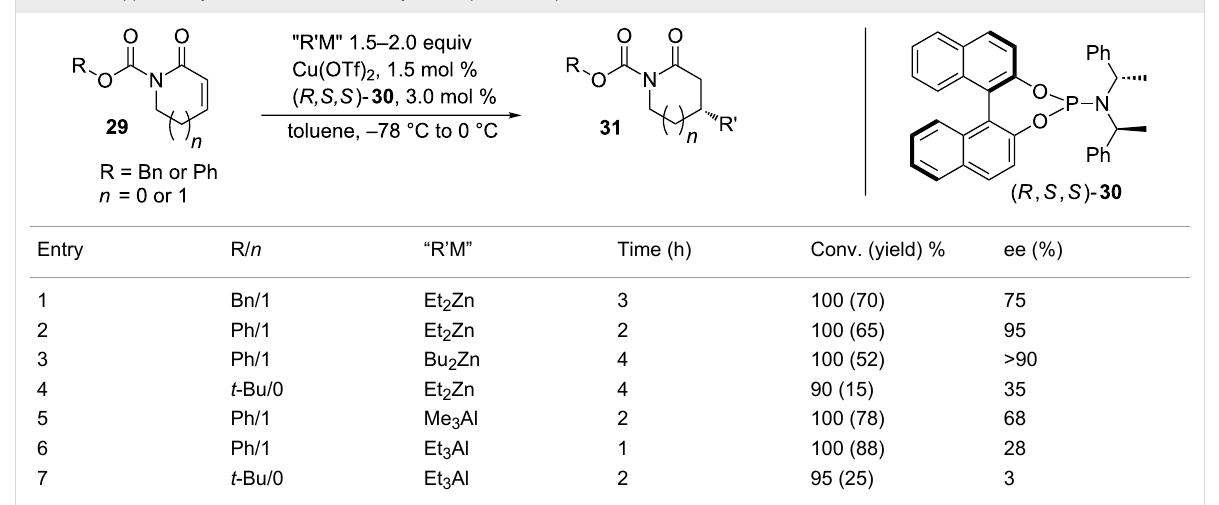
Table 1: Copper-catalyzed ECA reactions of alkyl nucleophiles to α , β -unsaturated lactams.